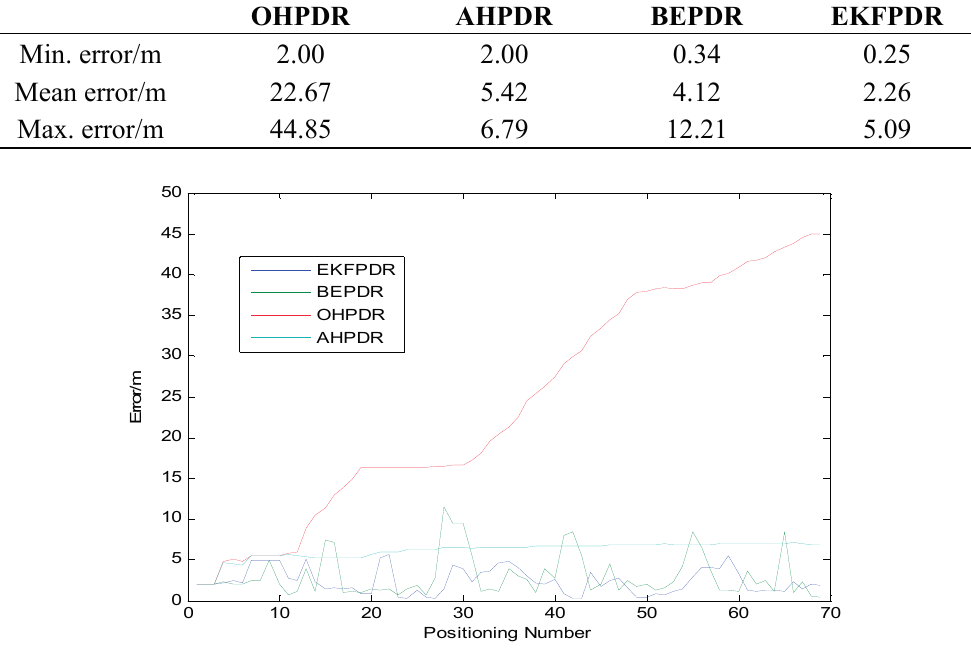
Figure 12. Positioning trajectory analysis for different solutions associated with PDR